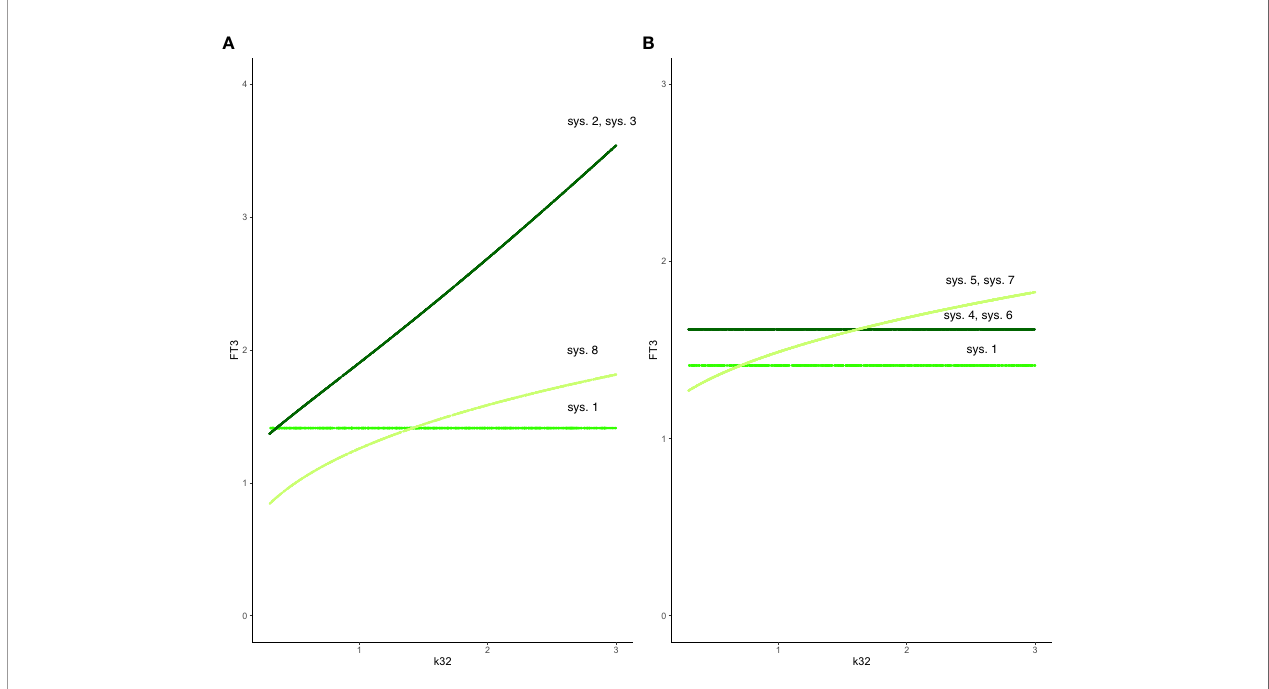
FIGURE 3 | Effect of feedback and feedforward mechanisms on FT3 homeostasis. (A) Unlike in system (sys. 1) (green line), the absence of feedback by both FT4 and FT3 onto TRH in system (sys. 2) or TSH in system (sys. 3) results in a loss of FT3 homeostasis, as k32 (FT4 production rate constant) varies (coinciding dark- green curves). The removal of positive feedforward of TSH onto FT3 in system (sys. 8) also results in a loss of FT3 homeostasis, as k32 varies (olive-green curve). (B) In both cases that the in fl uence of feedback by FT3 onto either TRH in system (sys. 4) or TSH in system (sys. 6) is constant, the level of FT3 homeostasis is shifted (dark-green curve), compared to system (sys. 1) (green curve), as k32 varies. In the other case that the in fl uence of feedback by FT4 onto either TRH in system (sys. 5) or TSH in system (sys. 7) is constant system, FT3 homeostasis is lost (olive-green curve), as k32